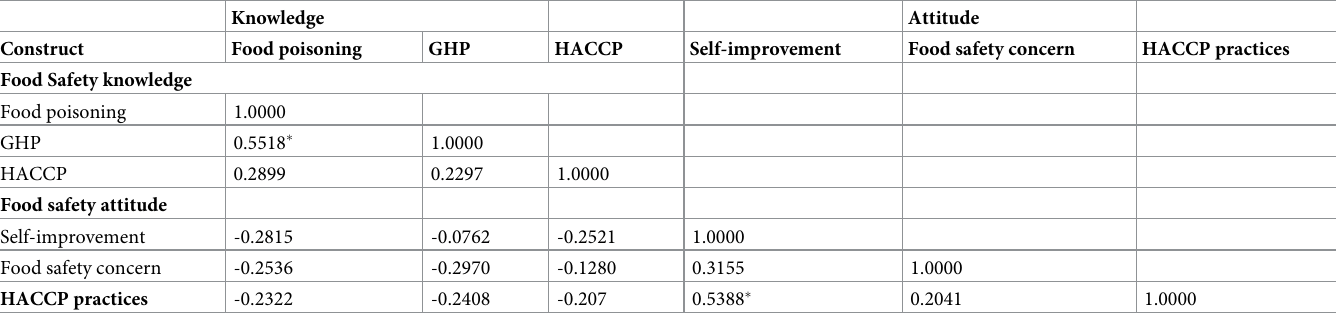
Table 5. Relationships among participant food safety knowledge, attitude, and HACCP practices of the participants (N =